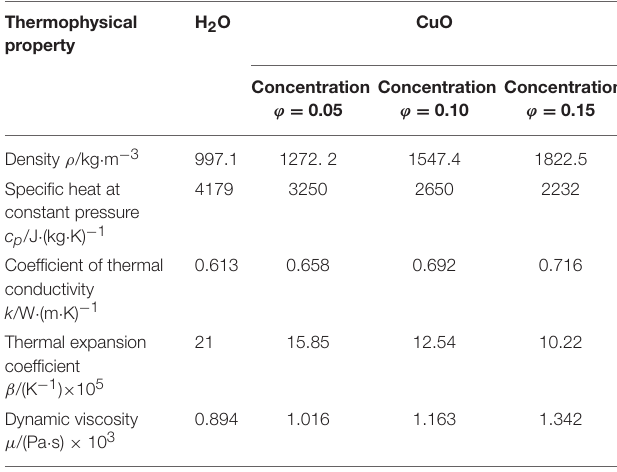
TABLE 2 | Water and concentration of nanofluids physical parameters (Sun et al.,